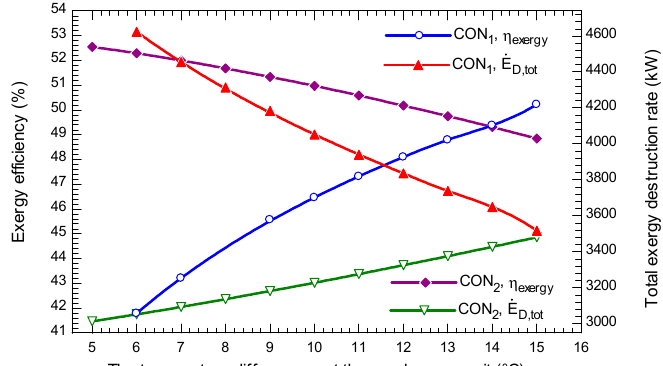
Figure 6. The variation of exergy efficiency and the total exergy destruction rate with the temperature differences at the condensers exit.